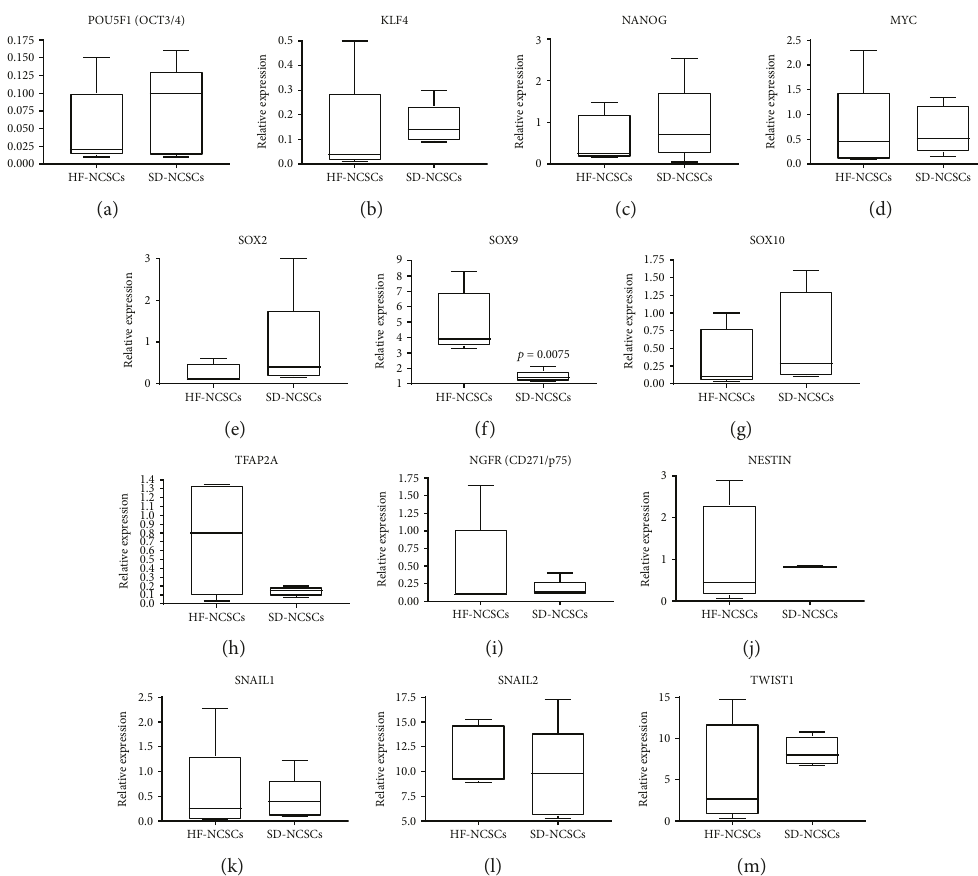
Figure 6: The mRNA expression levels of pluripotency, stemness, and neural crest markers for human NCSCs isolated from hair follicles and skin dermis; qPCR analysis. The expression of all target genes was normalised to TBP gene expression levels. The HF NCSC and SD NCSC cultures from fi ve donors were analysed. Box plots show quartiles, median, minimum, and maximum